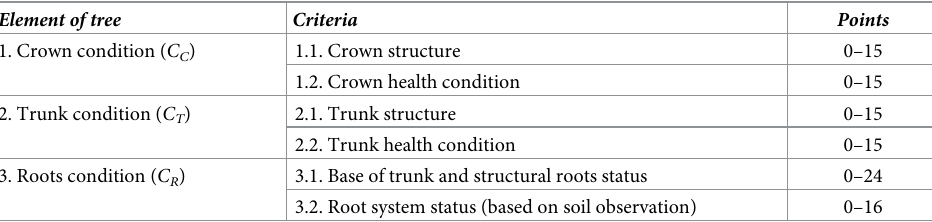
Table 2. Points range for each of the criteria. Element of tree Criteria